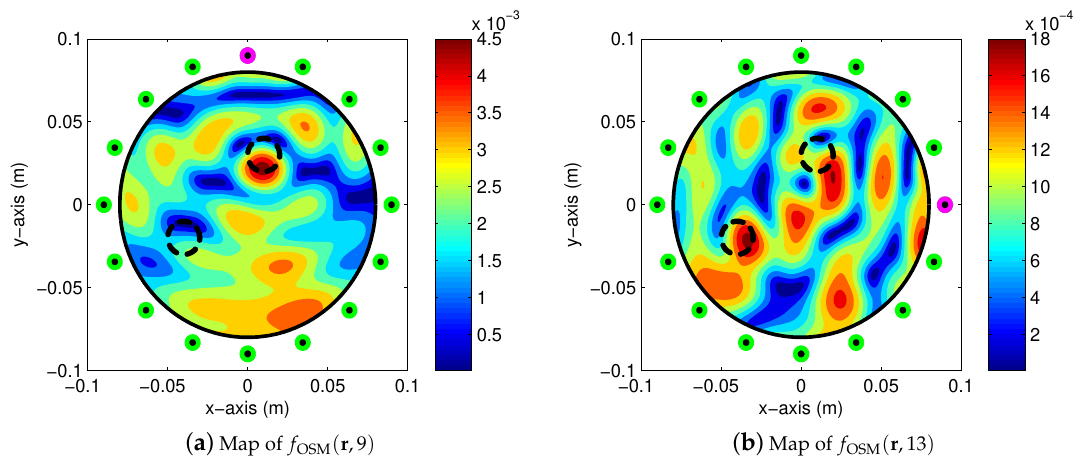
Figure 6. (Example 4) Maps of f OSM ( r , m ) . Black-colored dashed circles describe the boundary of